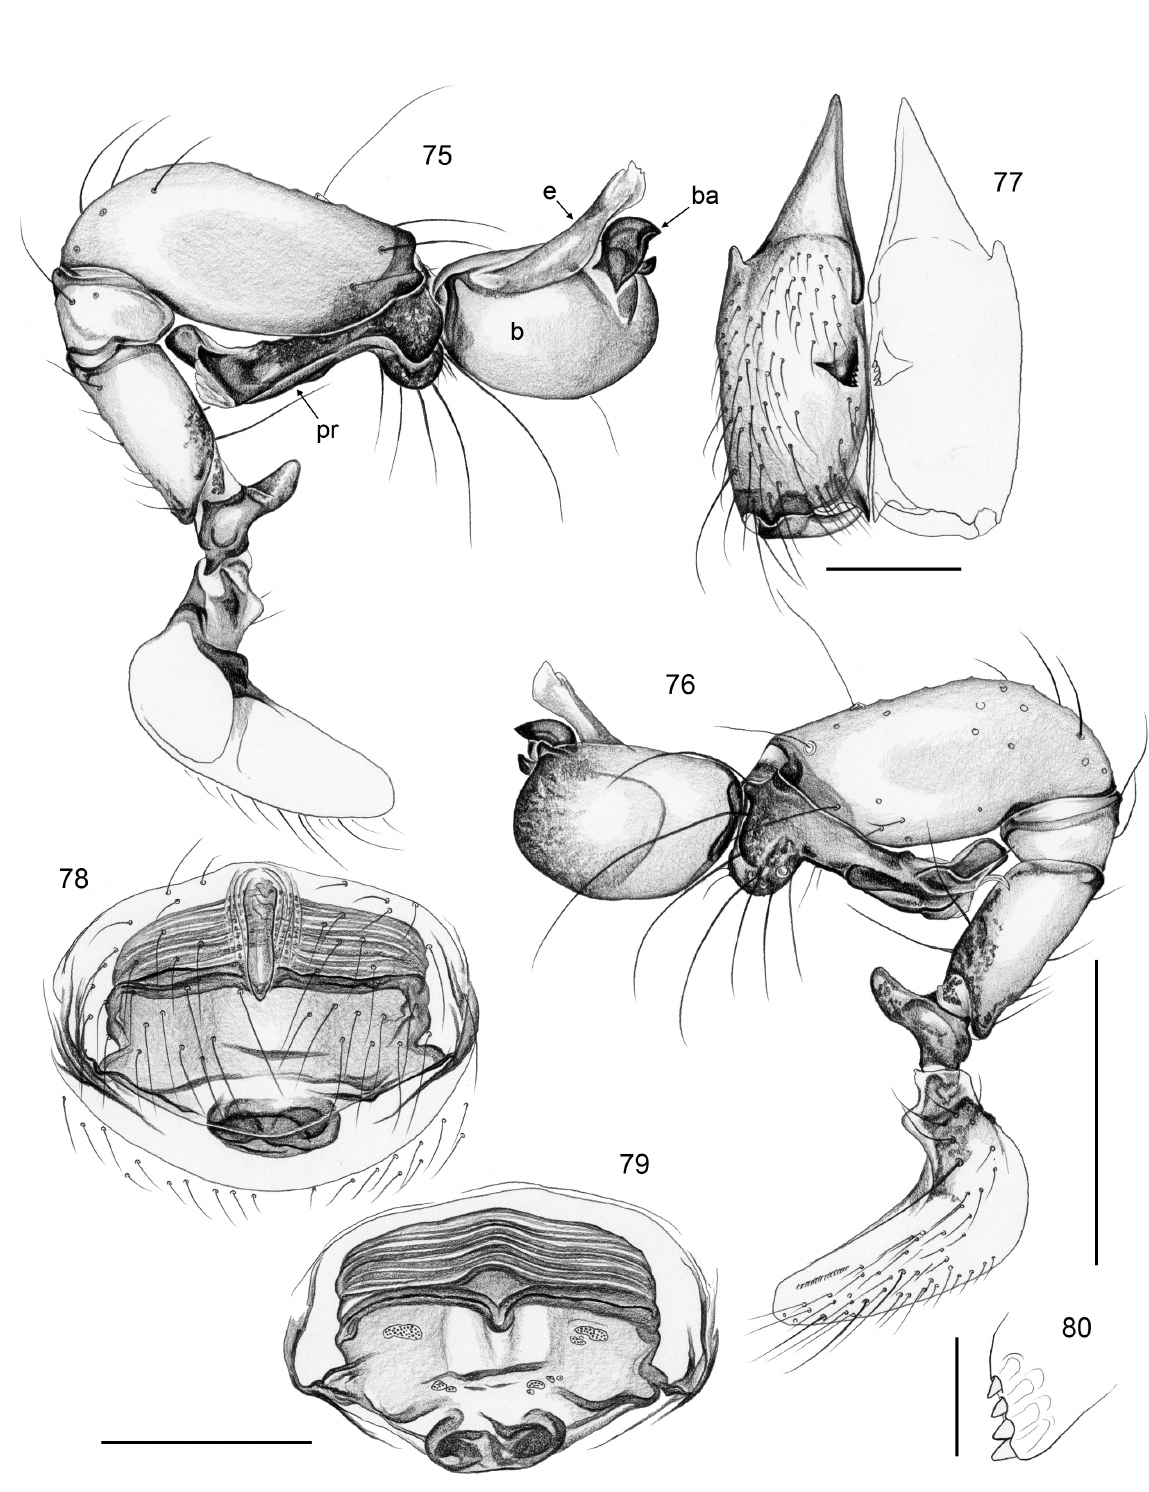
Figs 75-80. Buitinga wataita sp. nov. 75-76. Left ♂ palp, prolateral and retrolateral views. 77. ♂ chelicerae, frontal view. 78-79. ♀ genitalia, ventral and cleared dorsal views. 80. ♂ cheliceral apophysis with modified hairs. b: genital bulb; ba: bulbal apophysis; e: embolus; pr: procursus. Scale lines: 0.05 mm (80), 0.2 mm (77), 0.3 mm (78, 79), 0.5 mm (75,